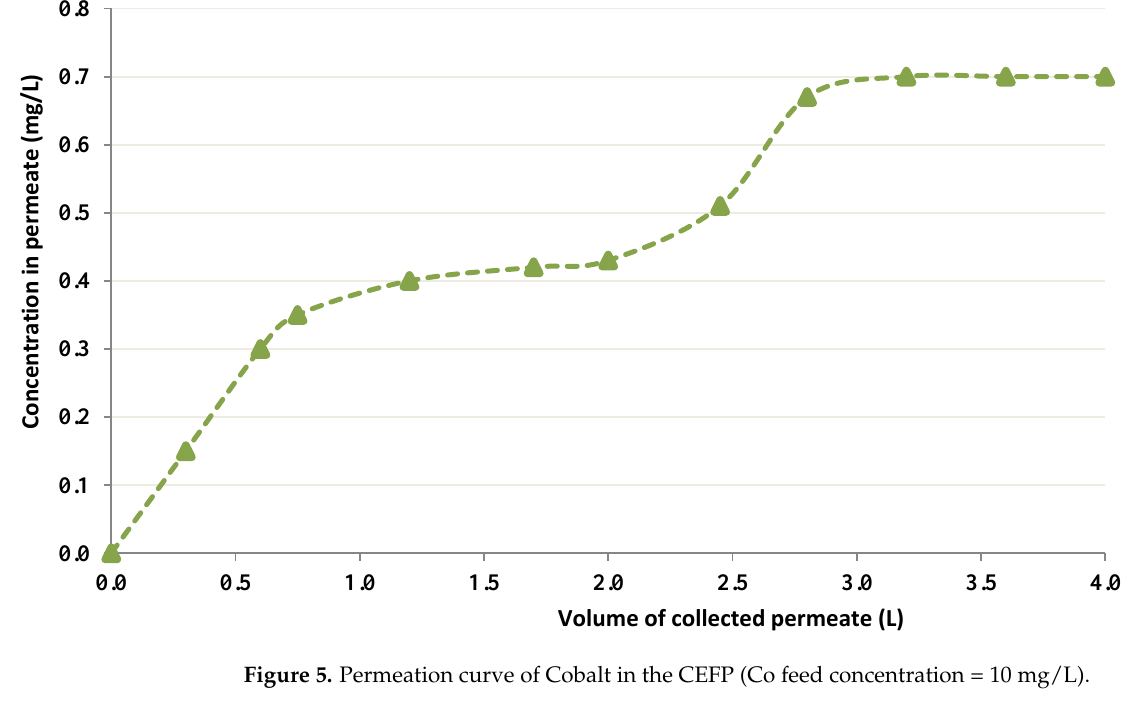
Figure 5. Permeation curve of Cobalt in the CEFP (Co feed concentration = 10 mg/L).